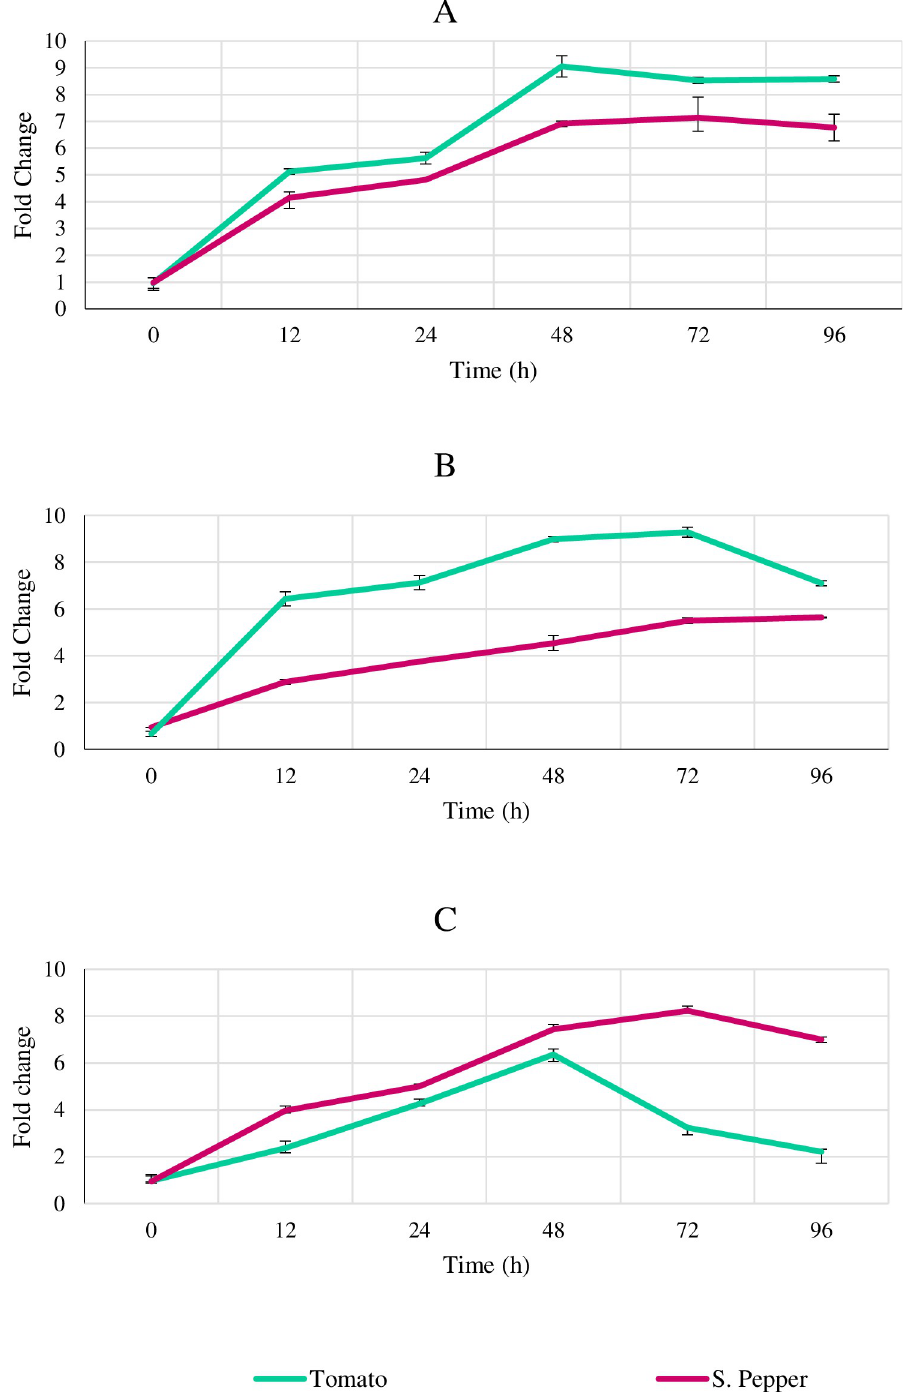
Fig 6. Real-time transcription of hormonal biosynthesis pathway genes following A . nodosum extract application in tomato and sweet pepper plants. Plant tissue was collected at time points (0, 12, 24, 48, 72 & 96h) after seaweed extract application and relative qPCR done to monitor transcripts for (A) IPT (B) IAA (C) Ga2Ox2 genes. The data was normalized using the house keeping gene β -actin. Data represents fold change in comparison to the control. The data are averages ± SD for 2 independent trials with 6 replicates. The data was analysed by repeated measures ANOVA at 95% confidence interval to study the effects of time and treatment. The data was also analysed by Student’s t-test to examine the significance of seaweed extract versus control at each time point